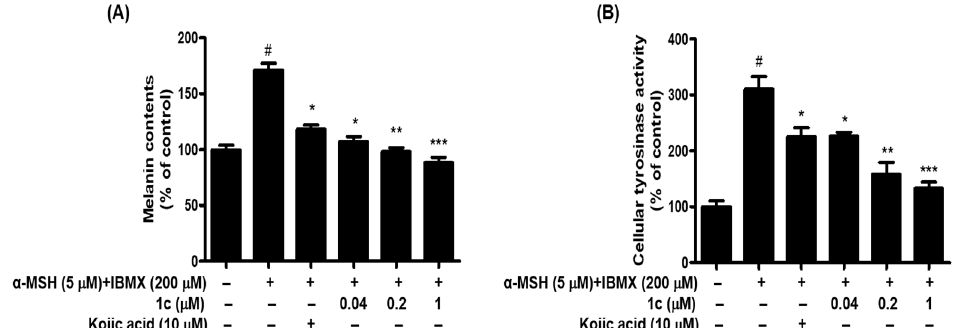
Figure 5. Effects of compound 1c on melanin contents ( A ) and cellular tyrosinase activity ( B ). B16F10 cells were exposed to α -MSH (5 µ M) and IBMX (200 µ M)-treated with 1c or kojic acid for 48 h. Data are representative the data of three separate experiments. Significance of 1c or kojic acid compared with vehicle-treated control, # p < 0.05; significance of 1c or kojic acid compared with α -MSH and IBMX-treated group, * p < 0.05, ** p < 0.01 and *** p < 0.001. Bars indicate standard errors of means (SEM).